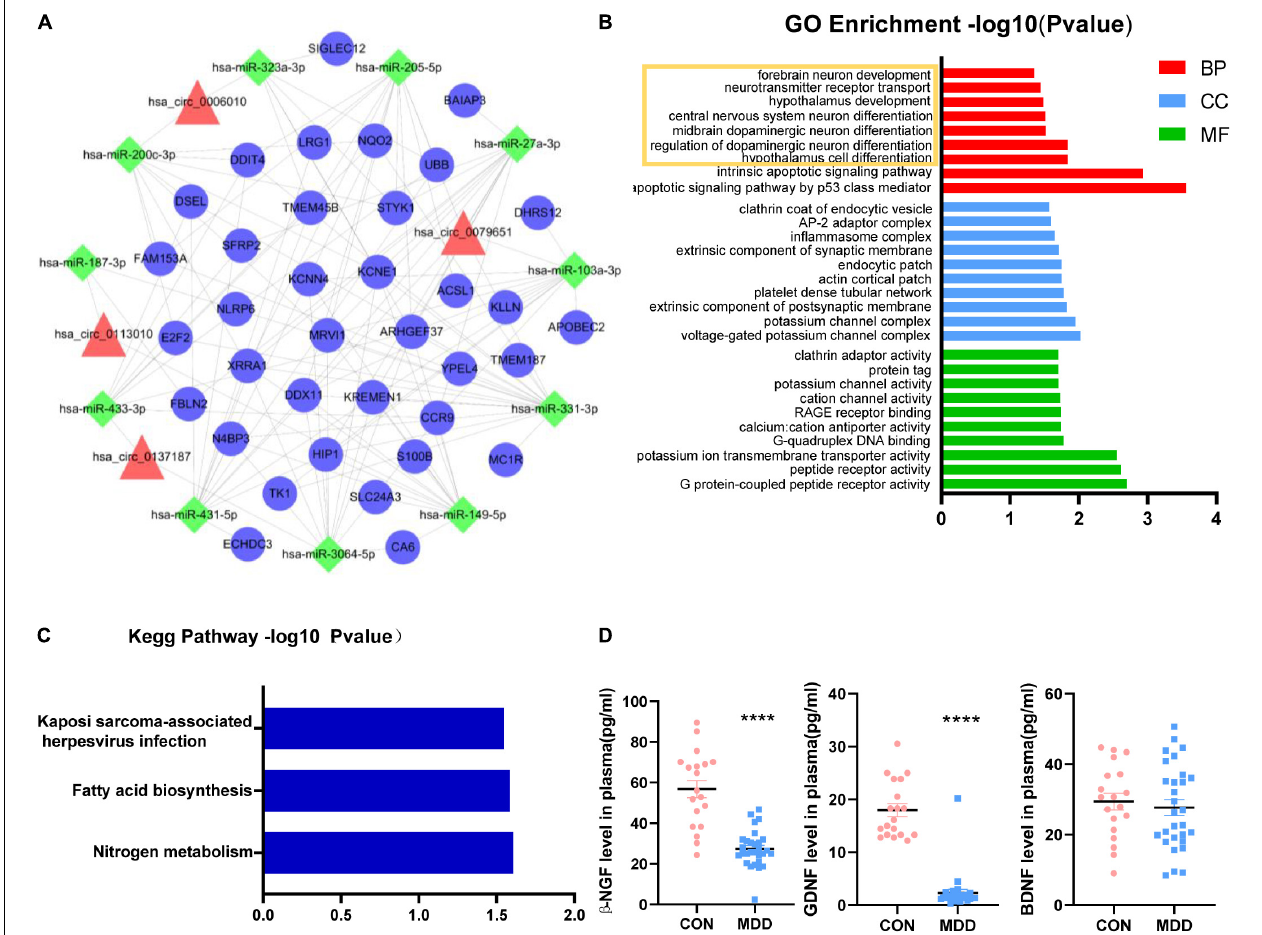
FIGURE 3 | Functional prediction of circHNRNPA2B1, circZFAND1, circDPY19L1P1, and circEPB41. (A) : CircRNA-miRNA-mRNA network. Four candidate circRNAs with their potential target 11 miRNAs and 36 mRNAs. Triangles represent circRNAs, squares represent miRNAs and circles represent mRNAs. (B) Part of GO enrichment analysis items based on 36 mRNAs that related to ceRNA network. (C) KEGG enrichment analysis based on 36 mRNAs that related to ceRNA network. (D) The plasma concentration of β -NGF, GDNF, and BDNF between 29 MDD patients and 19 healthy controls. Data are presented as mean ± standard error of the mean (SEM). **** p <